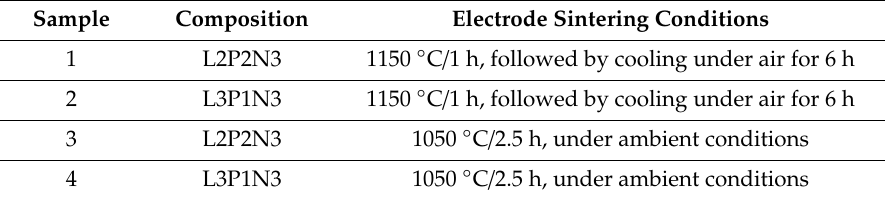
Table 1. Summary of the cell preparation conditions for the six samples